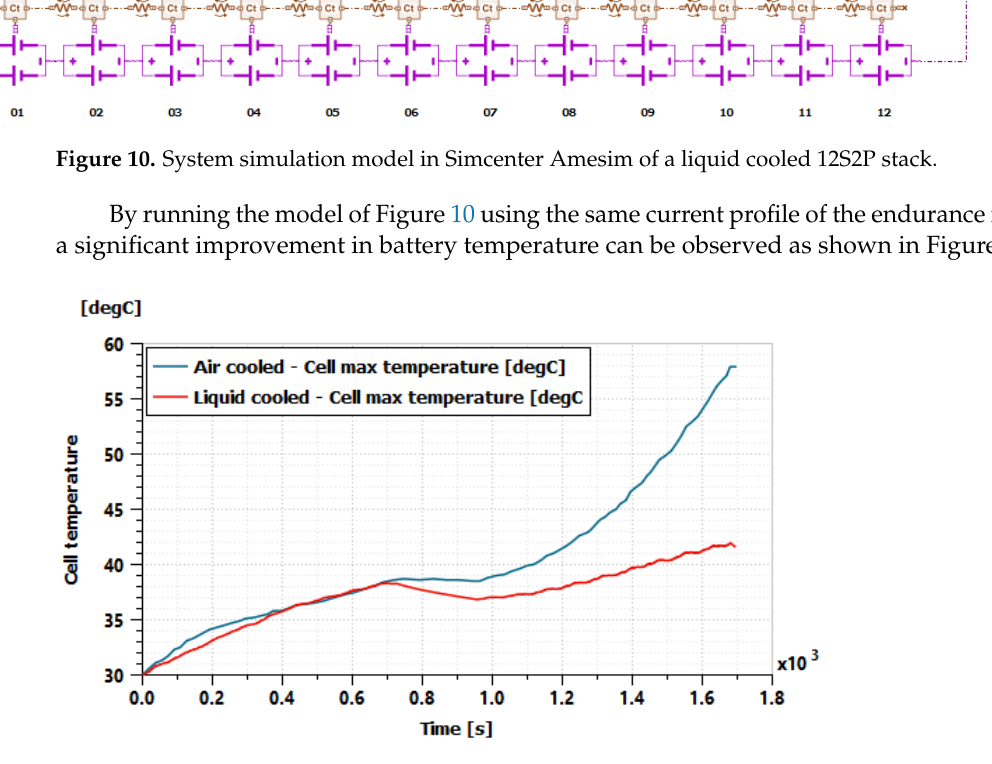
Figure 11. Simulation result of the battery maximum cell temperature with liquid cooling compared to that with air cooling.